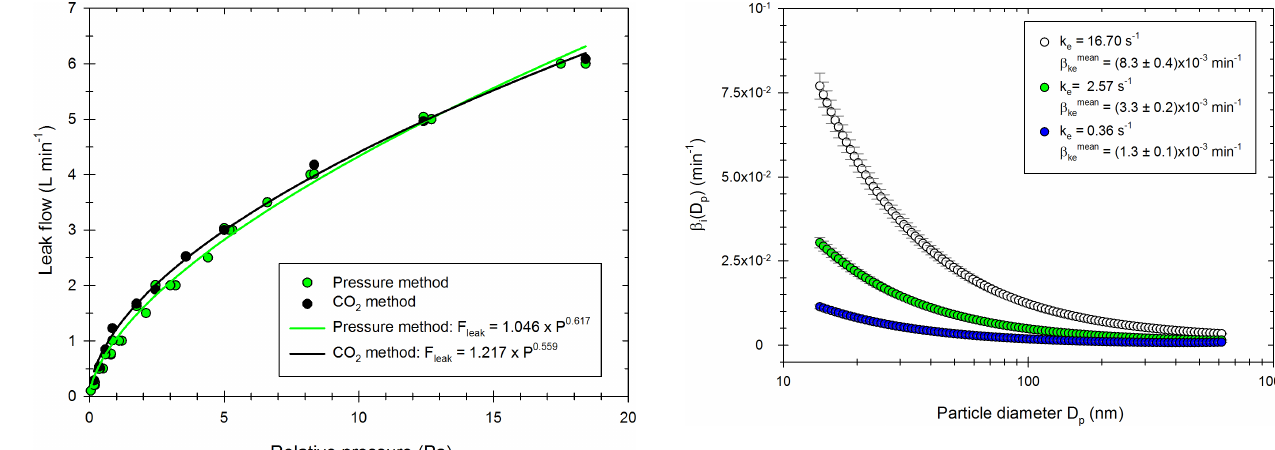
Figure 3. Distribution of the wall loss coefficient β i ( D p ) for three values of k e obtained experimentally: 16.70s − 1 (white), 2.57s − 1 (green) and 0.36s − 1